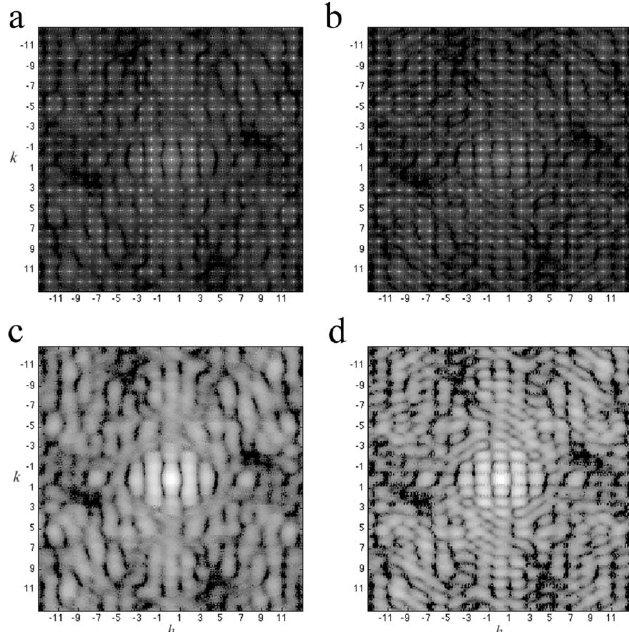
Figure 11 Classification of diffraction patterns from crystals with different numbers of partial unit cells at the boundary. Using the expectation maximization algorithm, the two classes of diffraction patterns are separated and the accumulated diffraction patterns are shown in ( a ), ( b ) for each class; the corresponding recovered molecular transforms are shown in ( c ), ( d